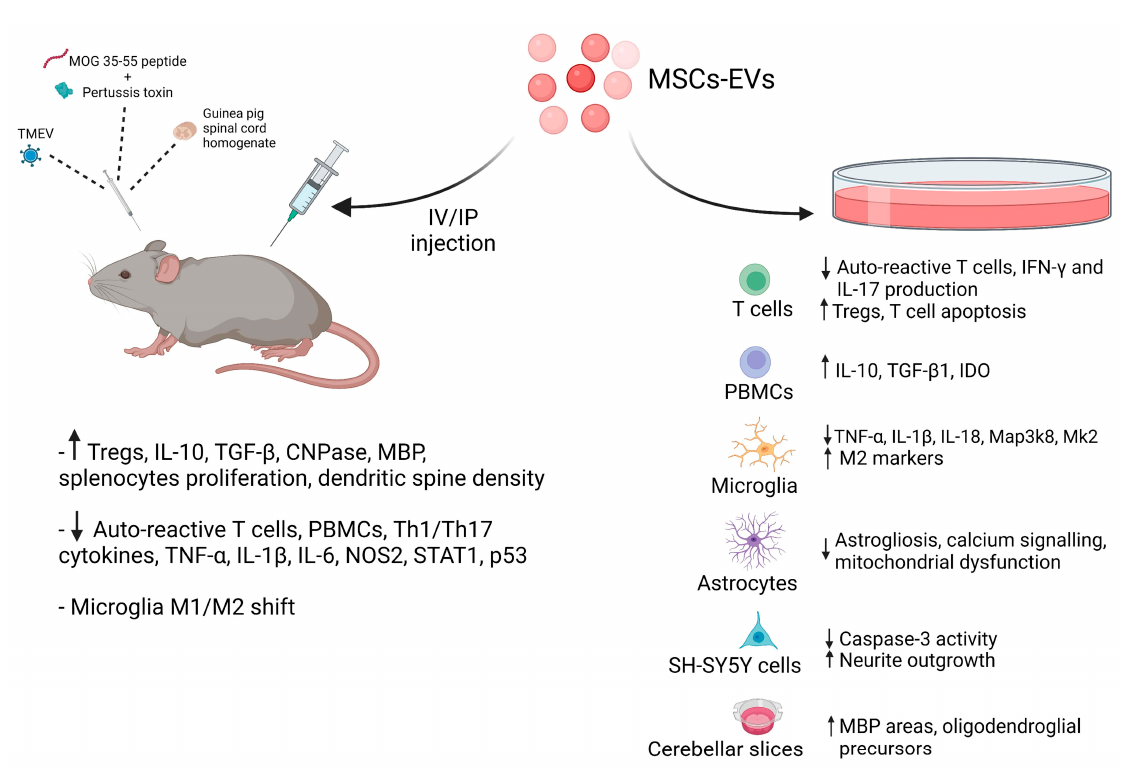
Figure 2. MSC-EVs’ in vivo and in vitro effects: Treatment with MSC-EVs showed their immunomod- ulatory, neuroprotective, and anti-inflammatory effects by enhancing Treg numbers and neurite outgrowth, and by diminishing pro-inflammatory cytokines (e.g., TNF- α , IL-1 β ) in favor of anti- inflammatory ones (e.g., IL-10, TGF- β ), in EAE animal models (injecting MOG 35–55 peptide/pertussis toxin, TMEV, or spinal cord homogenates) and in different cell cultures. Created with BioRen- der.com.